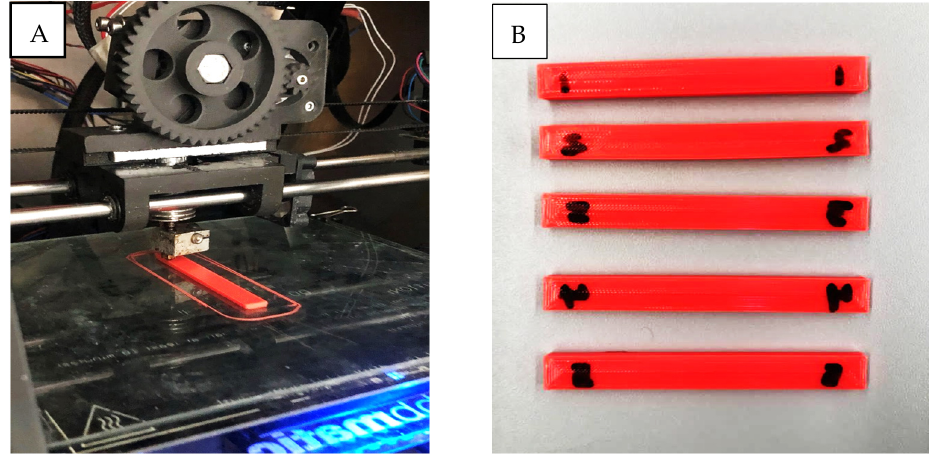
Figure 7. 3D printing of DIN EN ISO 75 samples. ( A -while printing, B -Printed Samples).